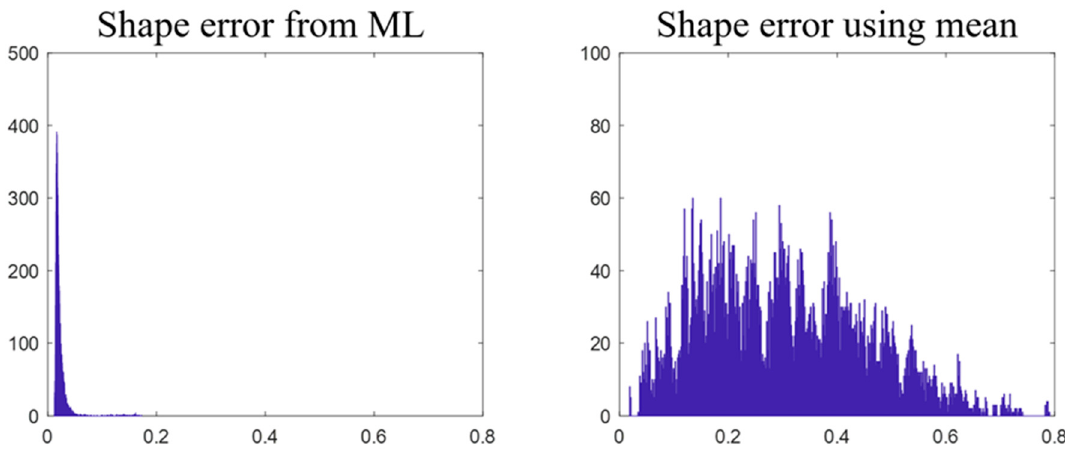
Figure 9. The left plot shows the MeanE (mm) distribution /histogram of shapes predicted by the 1st ML-model-a. The right plot shows the MeanE (mm) distribution of shapes predicted by using the mean shape.